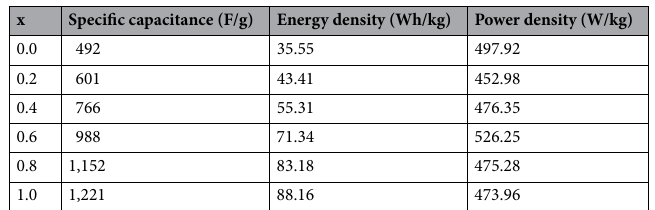
Table 3. Specific capacitances, energy densities, and power densities of the electrodes constructed from the prepared Ni